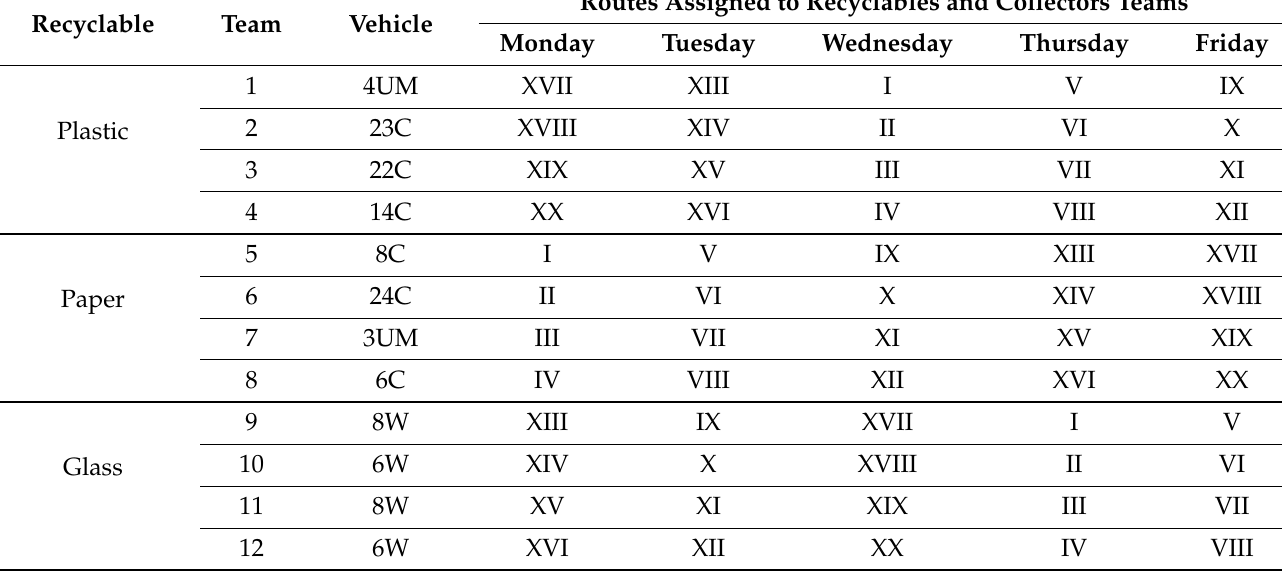
Table 1. An exemplary weekly assignment of 20 routes for selected recyclables collection (I–XX) to 12 garbage collectors teams and vehicles in the agglomeration of Cracow,